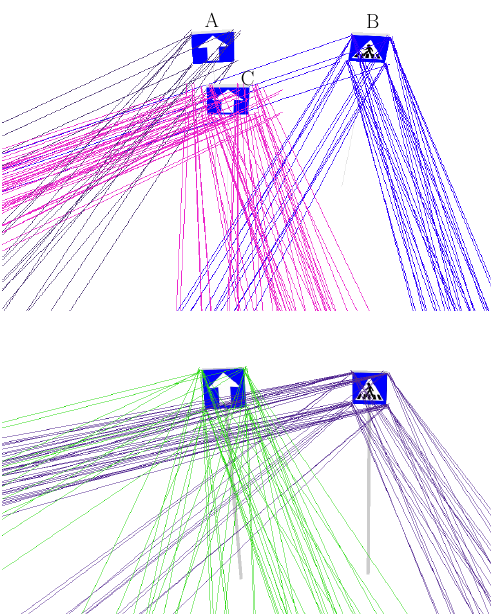
Figure 4: An ambiguous clustering problem. Top: a greedy heuristic generates a "ghost" 3D signs at C when reconstruct- ing the real signs A and B. Bottom: our combinatorial clus- tering successfully removed C, reattributing all 2D detections to the correct 3D sign, also improving